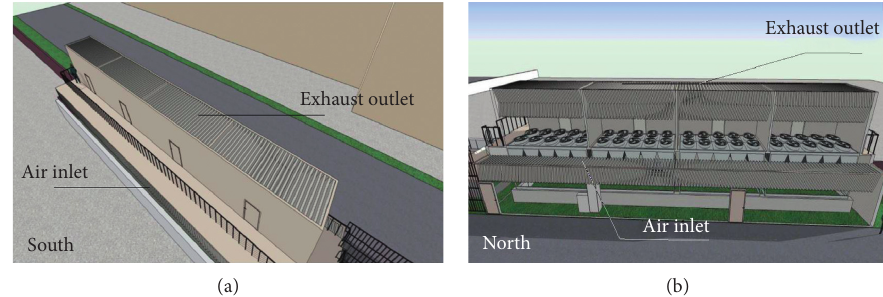
Figure 2: The schematic diagram of the sound shield for the heat pump unit.